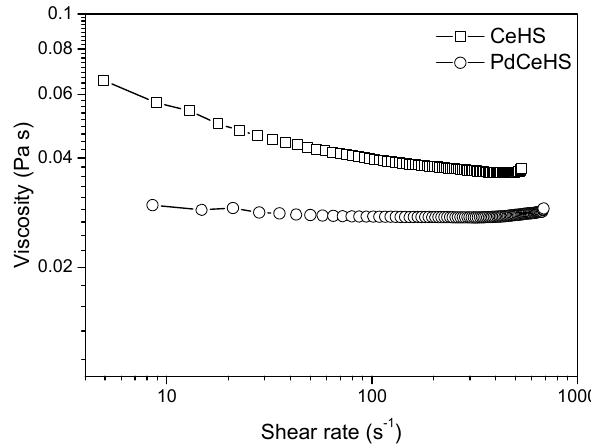
Figure 3. Flow curves of CeHS and PdCeHS slurries.